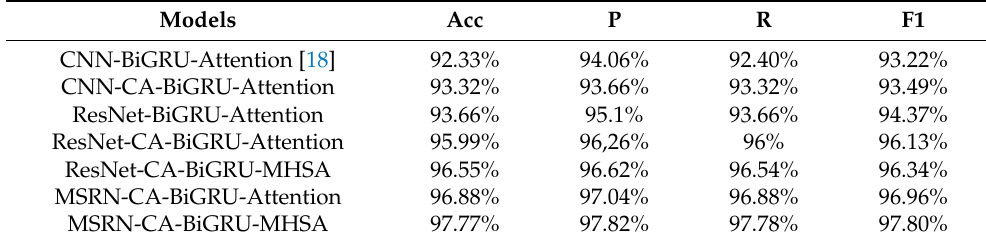
Table 4. Experimental results of the Common Voice dataset.